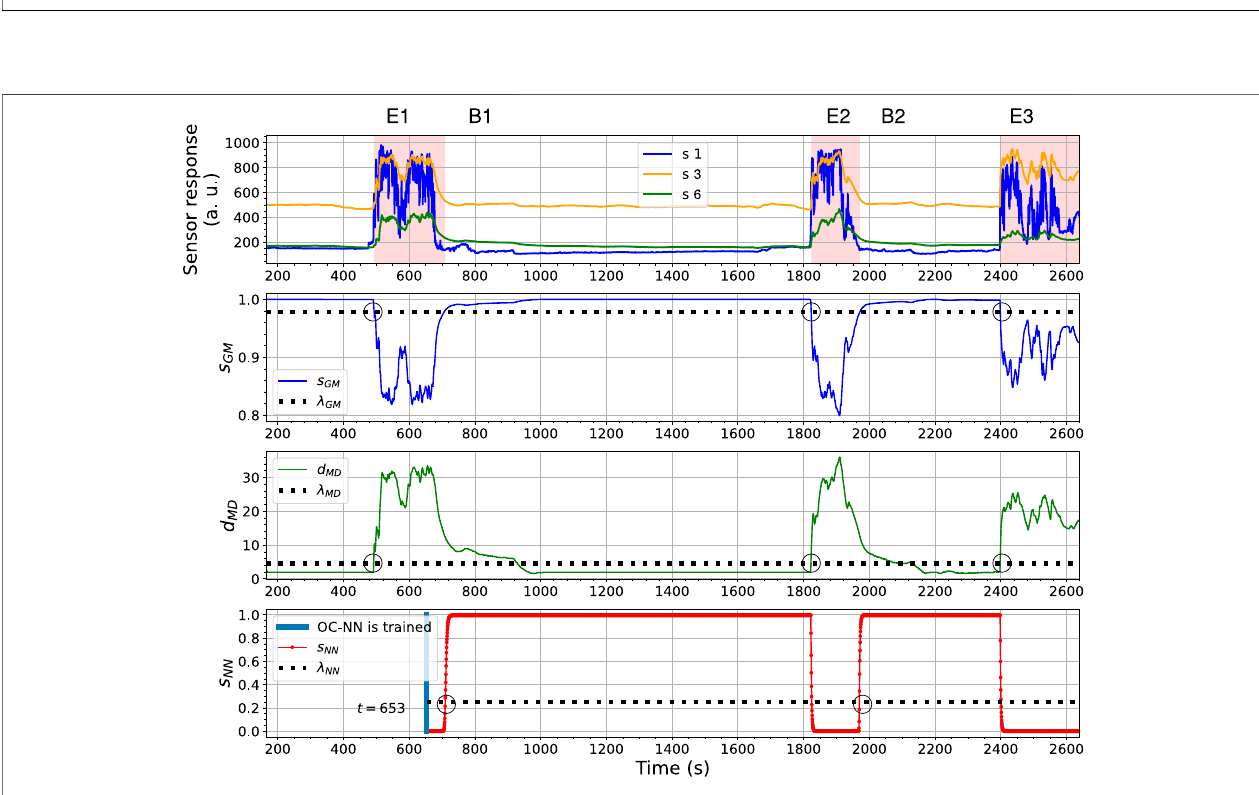
FIGURE 13 | The outputs changes of the OC-Gaussian, the OC-Mahalanobis, and the OC-NN models using ORU nose in the Exp. 3-source trial. The gas responses recognized by the ensemble model are in red shade in the sub- fi gure at the top.